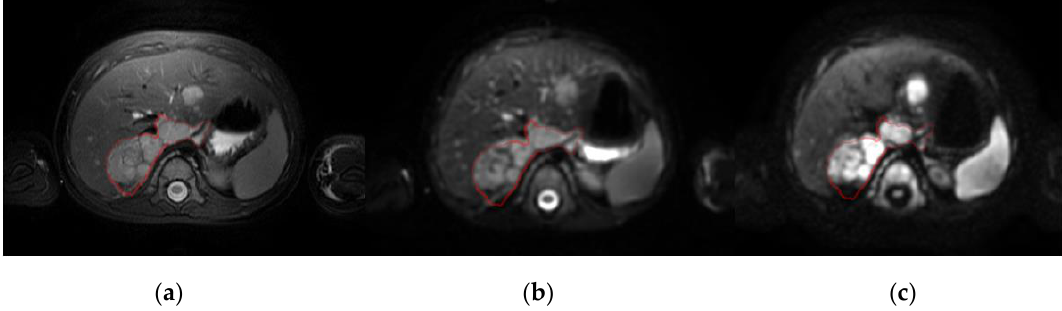
Figure 1. Baseline MRI of a patient with neuroblastoma in the right adrenal gland and liver metastasis shown on: ( a ), a T2-weighted image; ( b ), a DW image with b = 0 s/mm 2 ; and ( c ), a DW image with b = 800 s/mm 2 (right). The red line defines the primary tumor.